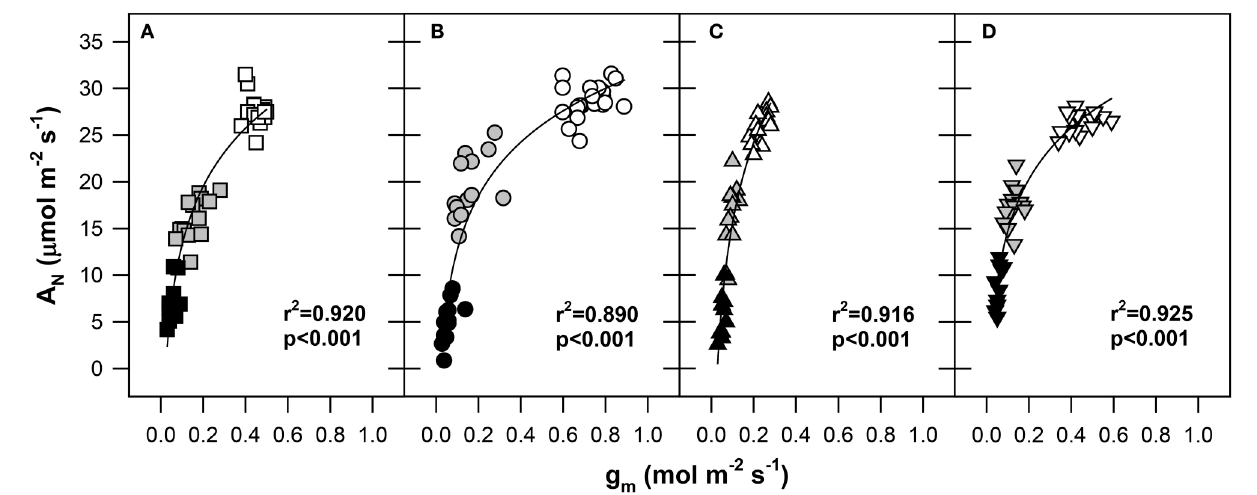
symbols are the same as in Figure 2 . The coefficients of determination ( r 2 ) and significance level ( p ) as well as the line of logarithmic regressions are shown in the plot.